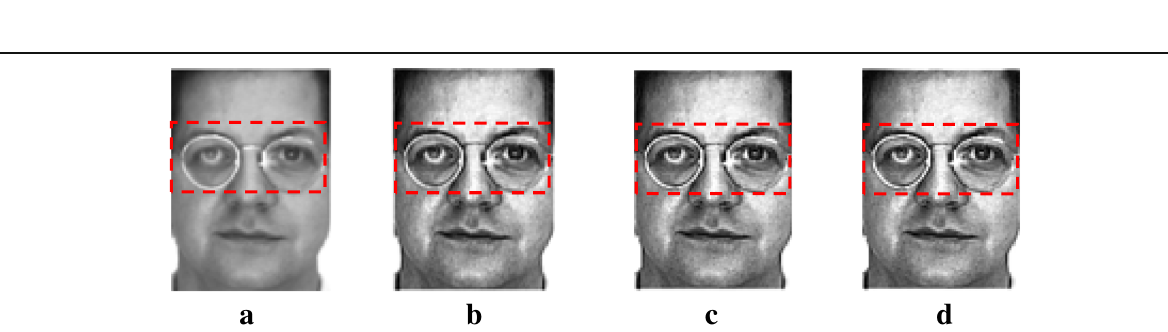
Fig. 4 Qualitative comparison of the different metaheuristic algorithm with our proposed evaluation function on Image 2. a Original. b CSO + proposed evaluation method. c PSO + proposed evaluation method. d GA + proposed evaluation method